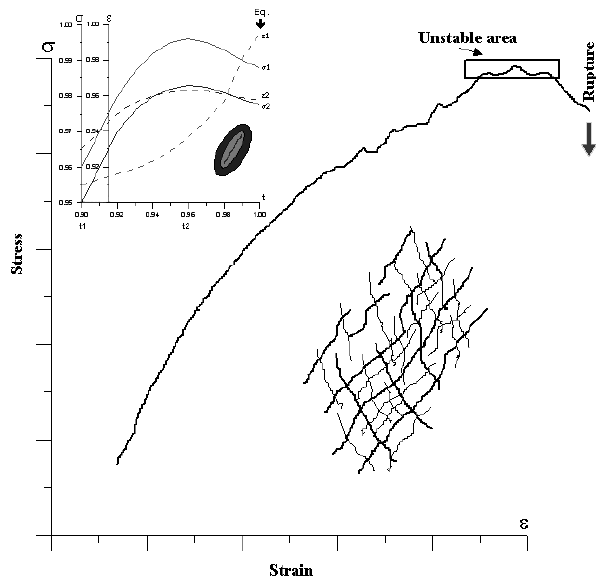
Fig. 1. A rheological diagram σ - ε near the long-term strength limit: in the top left corner – the process development diagram; in the Figure 1. A rheological diagram σ-ε near the long-term strength limit: in the top left corner – the 3 bottom right corner – structure diagram of distribution of blocks process development diagram; in the bottom right corner – structure diagram of distribution of 4 and faults in rock massif. Other explanations – in the blocks and faults in rock massif. Other explanations – in the text. 5